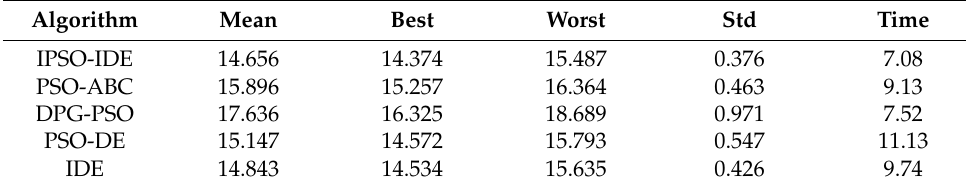
Table 7. Path planning results of different algorithms in environment 4.